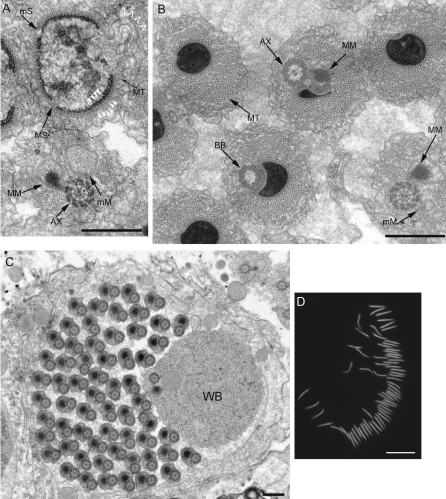
Spermatogenesis of Double-Mutant dox; nmy Is Normal(A–C) TEM images of sperm maturation.(A) Early post elongation stage of a spermatid head (upper) and tail (lower). Normal nuclear condensation can be seen apposed to rows of microtubules (white arrowheads), while nucleoplasm is eliminated (v).(B) Late post elongation stage of spermatid heads with homogeneously condensed nuclei (upper left and right). Also note the normal head-tail alignment (middle) and the tail (lower right).(C) Post individualization stage of a sperm bundle with 61 normal tails and one degenerated tail in the waste bag (WB).(D) DAPI images of 64 spermatid heads in a bundle at the stage of post elongation.Abbreviations used in annotation: AX (axoneme); BB (basal body); mM (minor mitochondrial derivative); MM (major mitochondrial derivative); mS (minor strip); MS (major strip); MT (microtubule); WB (waste bag). Scale Bars: 500 nm (A–C); 20 μm (D).